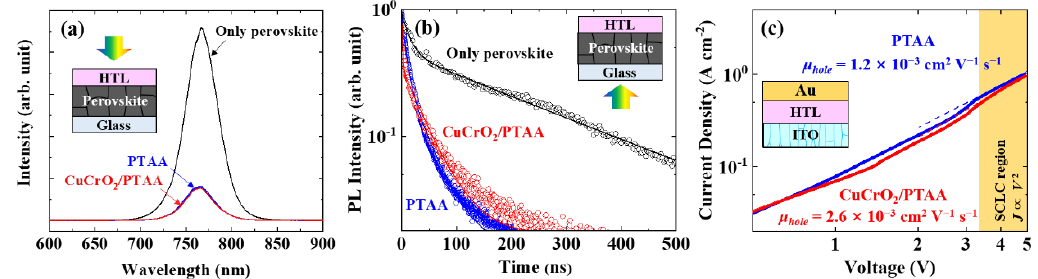
Figure 2. Electronic properties of CuCrO 2 /PTAA HTL: ( a ) Steady-state photoluminescence (PL) and ( b ) time-resolved PL spectra (398-nm excitation with fitting lines) of bare perovskite and perovskite/HTL films deposited on glass; ( c ) Dark J-V characteristics of ITO/HTL/Au layers with different HTLs, where space-charge limited current (SCLC) region is indicated.